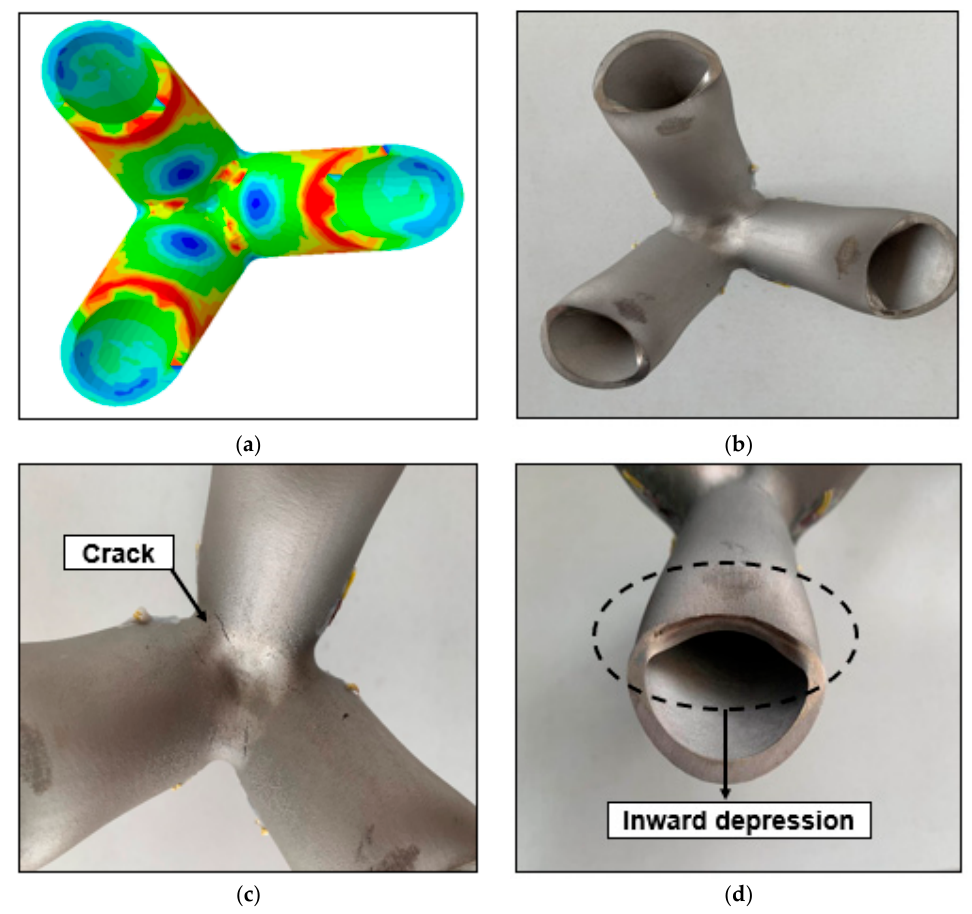
Figure 18. Results comparison: ( a ) numerical result; ( b ) test result; ( c ) end detail; ( d ) intersection detail.